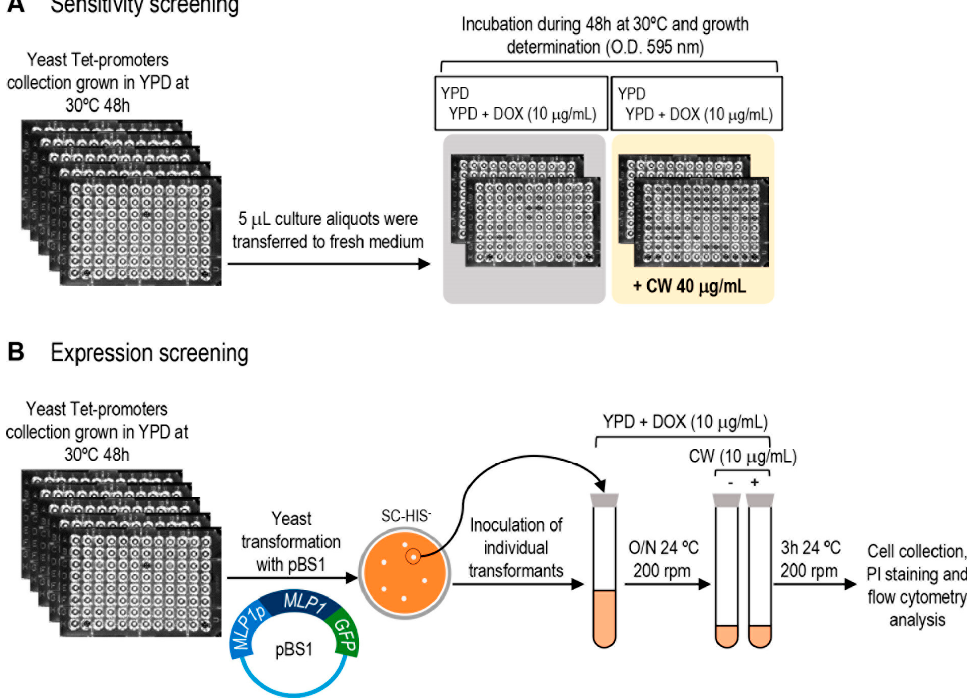
Figure 1. Overview of the screening strategies designed to identify cell wall-related mutants in essential genes. ( A ) Hypersensitive phenotype to Calcofluor white was studied in a 96-well microtiter plate format. ( B ) Detection of altered expression levels of the CWI-reporter gene KDX1 / MLP1 . The complete yeast Tet-promoter collection was transformed with the plasmid pBS1 ( MLP1p-MLP1-GFP ) and individual transformants were tested for Mlp1-GFP expression in the presence or absence of Calcofluor white (CW) by flow cytometry. DOX: exposure to doxycycline at the indicated concentration. PI: Propidium Iodide. Table 1. List of genes selected from the screening for Calcofluor white (CW) hypersensitivity, ordered according to their Gene Ontology annotations. CW sensitivity indicates the level of growth affectation in the presence of CW, from 0.0 (maximum effect) to 1.0 (absence of effect).